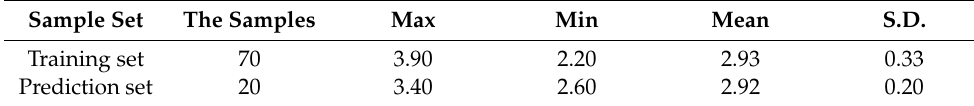
Table 1. Statistical results of the pH measurement values of